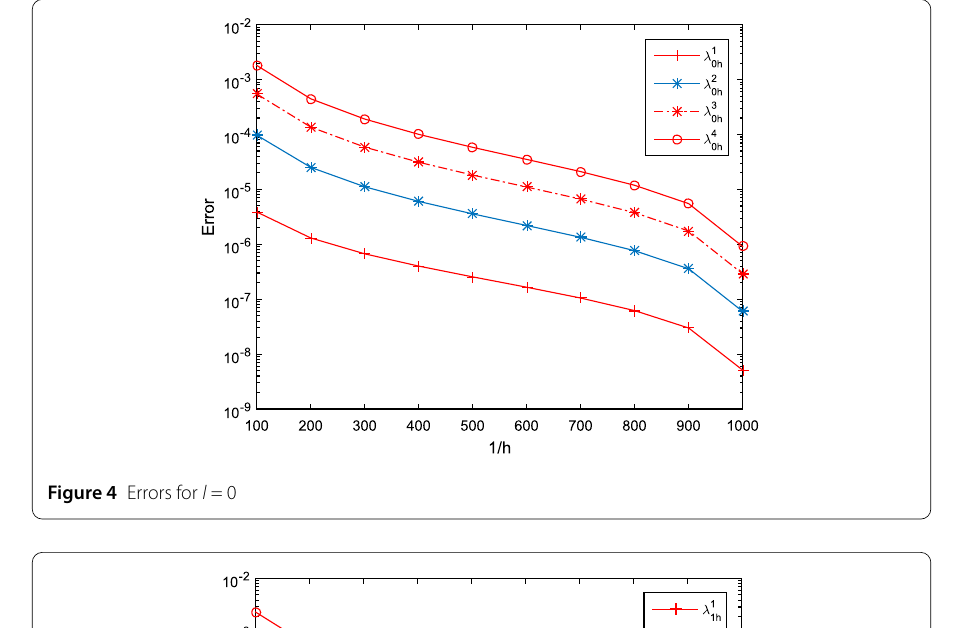
Figure 4 Errors for l = 0